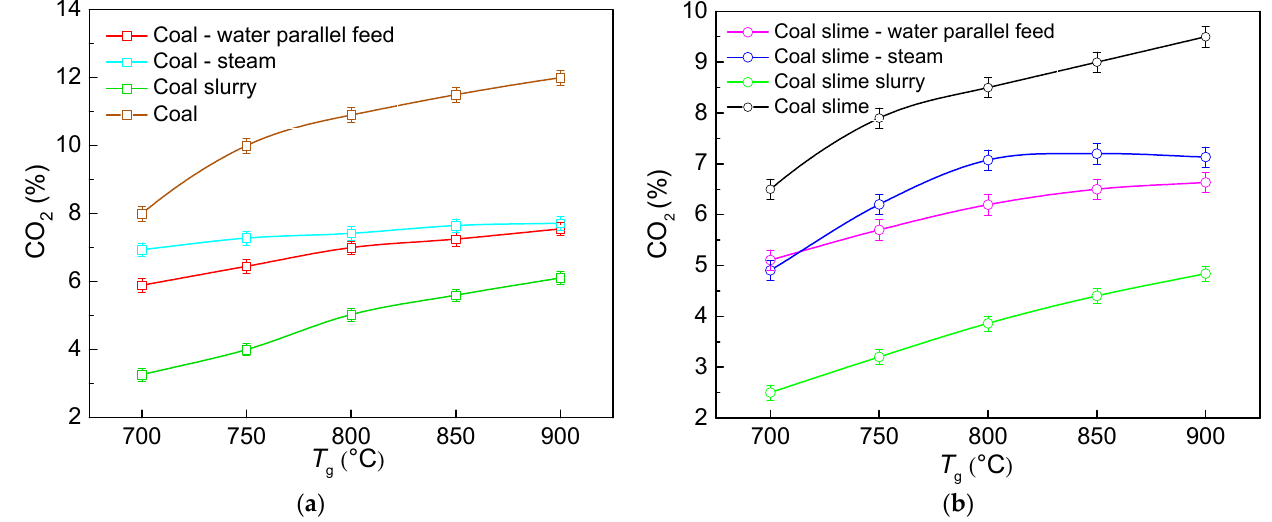
Figure 10. Average concentrations of carbon dioxide when varying the method of introducing the coal component (coal ( a ) and coal slime ( b )) and water, as well as the temperature in the combustion chamber.